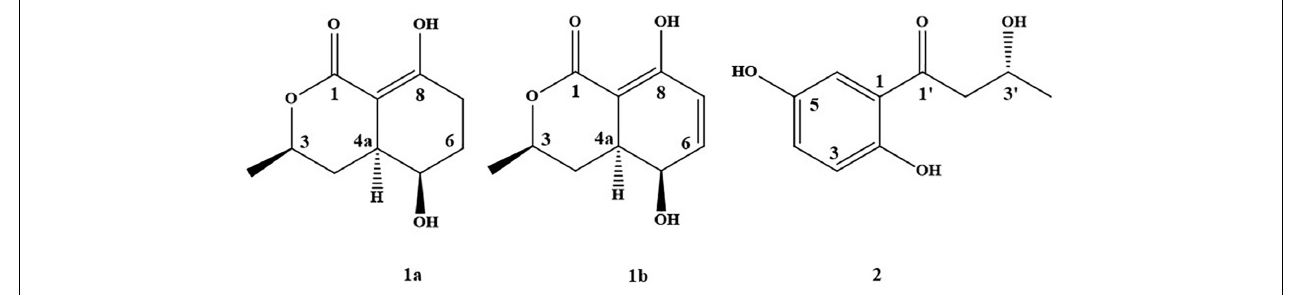
FIGURE 2 | The structure of compounds 1 and 2 .